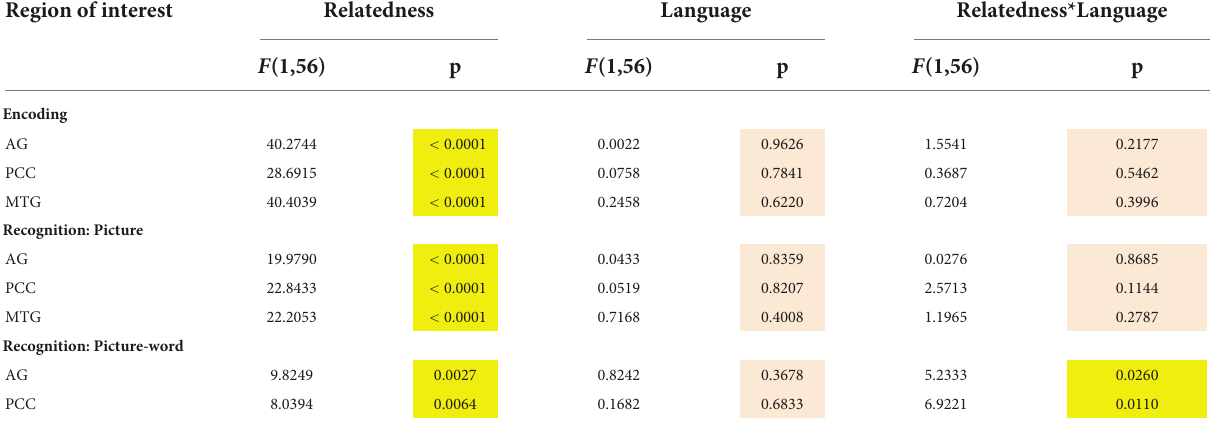
TABLE 6 Modulation of semantic congruency effects on neural activity by language. Region of